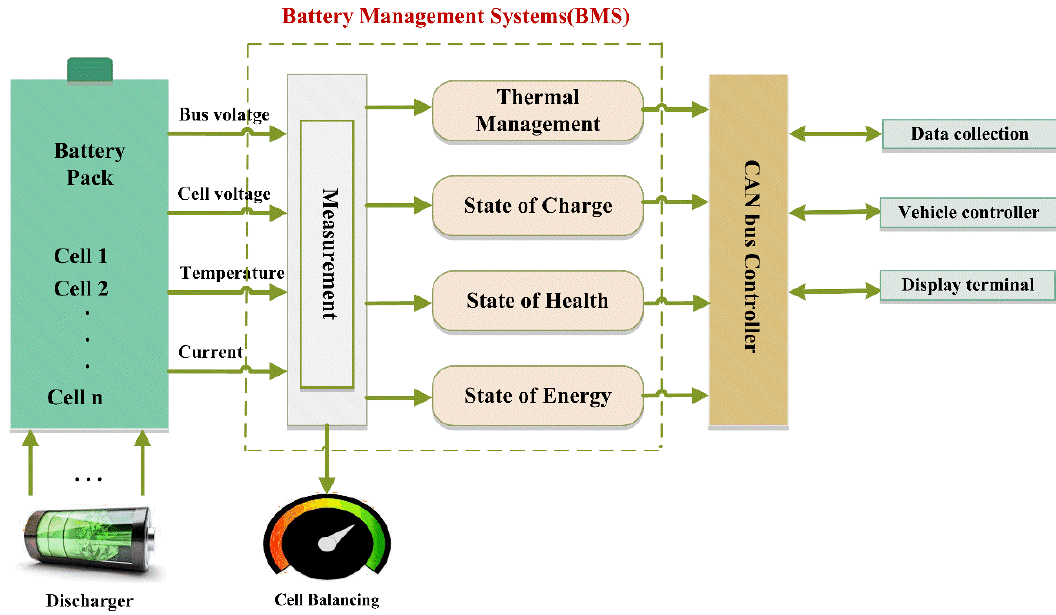
Figure 2. The general role of a BMS [37].